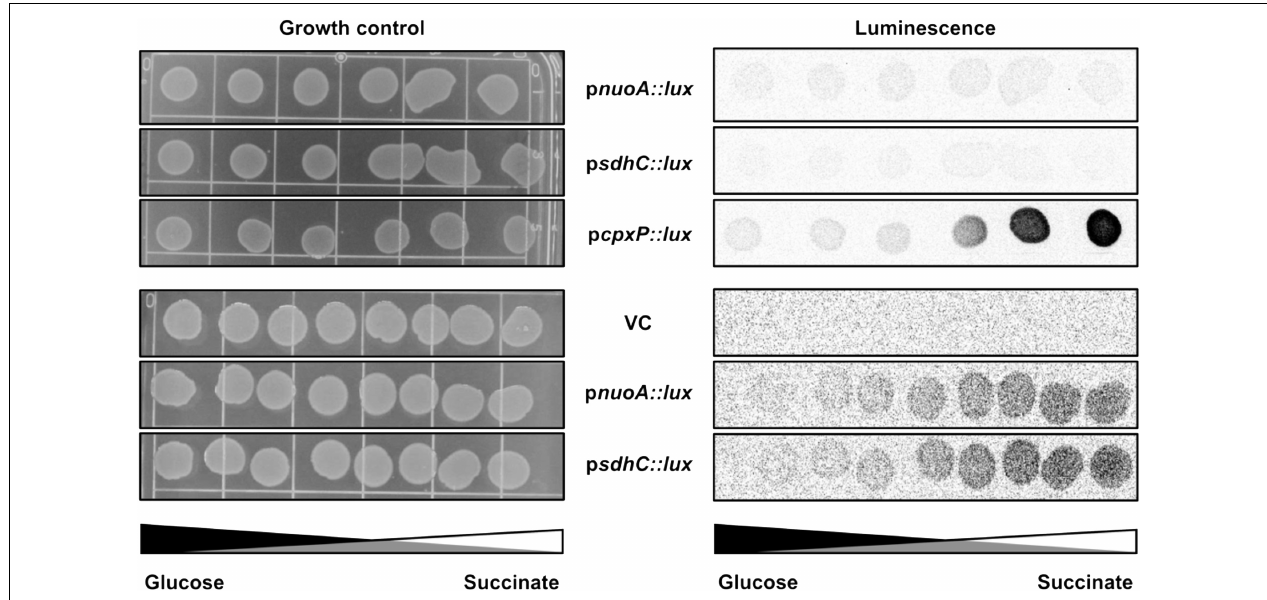
FIGURE 3 | Demand for aerobic respiration due to the presence of non-fermentable carbon sources induces the Cpx pathway. Luminescence activities are shown for wildtype E . coli MC4100 harboring either pJW15 (vector control) or the p nuoA :: lux , p sdhC :: lux , or p cpxP :: lux reporter plasmids. Luminescence of the strains growing on M9 minimal media plates containing a gradient of 0.4% glucose and 0.4% succinate, pH 7.0 was determined by imaging the luminescence of the spots after 48 h of incubation at 37 ◦